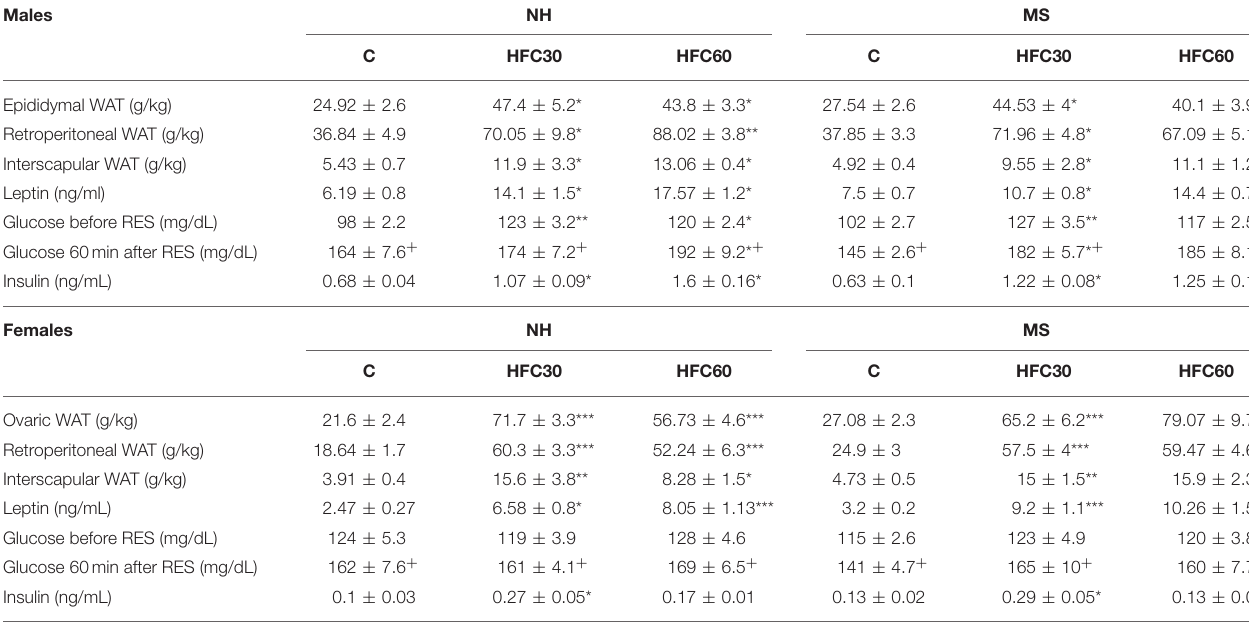
TABLE 2 | Effect of maternal separation and 3–4 months of a high-fat/high-carbohydrate diet on metabolic parameters in acutely restrained rats (experiment 2). Males